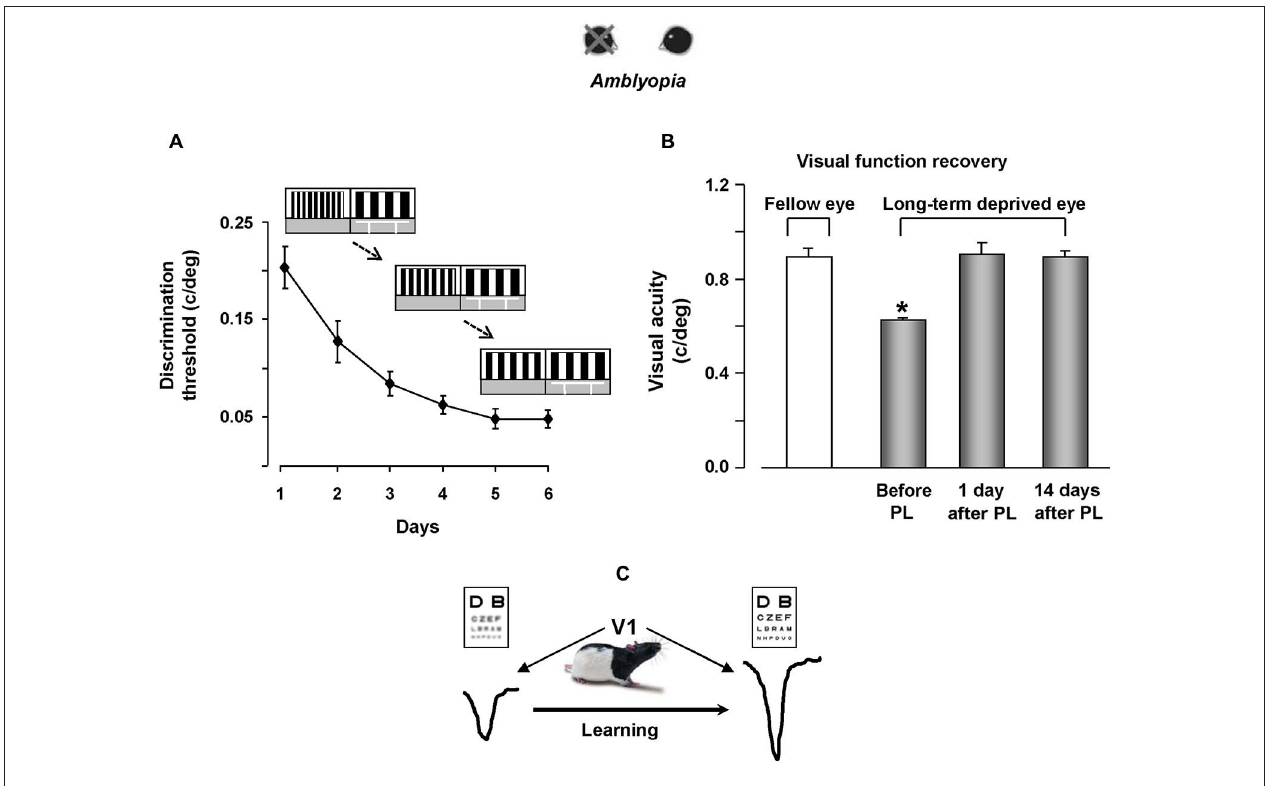
long-term deprived and the open eye is measured using the visual water box task. At the end of the PL procedure, visual acuity of the previously deprived eye is not different from that of the fellow eye, an effect outlasting the end of the treatment by at least 2 weeks. (C) We propose a model in which recovery of visual functions for the long-term deprived eye is driven by potentiation of synaptic transmission elicited by visual